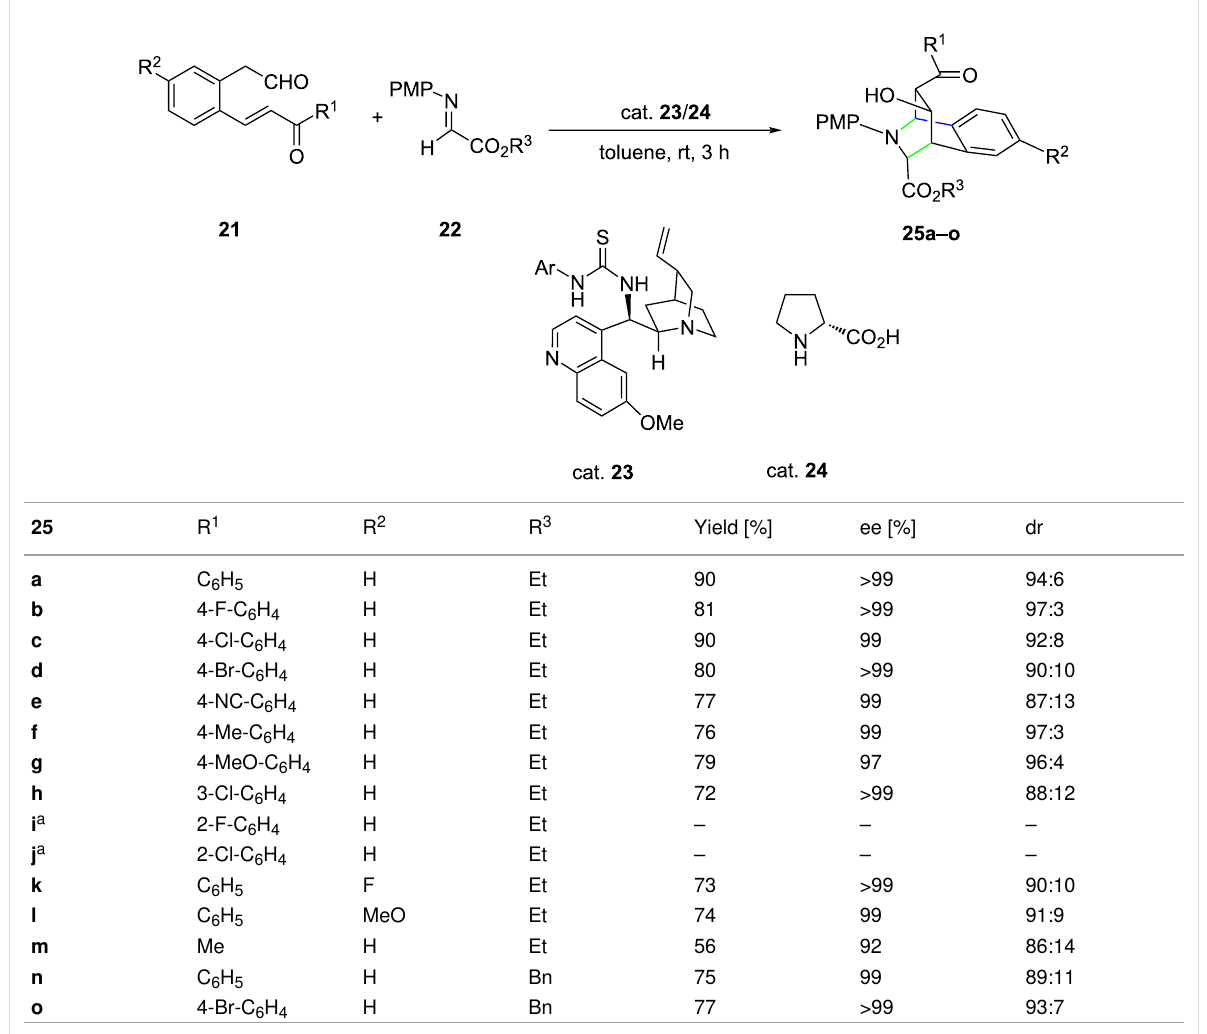
Table 5: Diastereoselective synthesis of bridged 1,2,3,4-tetrahydroisoquinoline derivatives using modularly designed